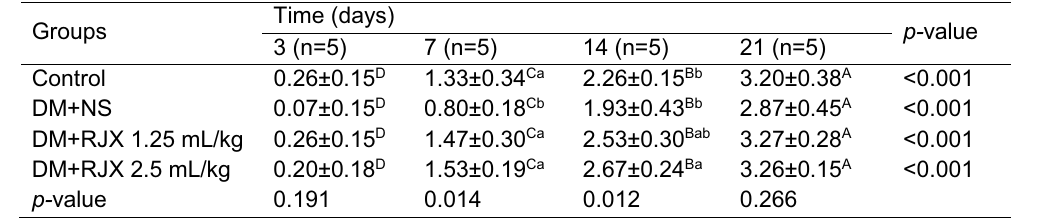
FIGURE 4 | Histopathological Scores of Wound Healing by Presence of Diabetes and Treatment Group. (A – D) Histopathological scores for wound healing for the healthy control vs. diabetic rats. The depicted scores represent the median and min-max. Statistical signi fi cance between groups is shown by *p<0.05 as compared to the healthy control group, and # p<0.05; ## p<0.01 as compared to the DM+NS group. Kruskal Wallis and Mann Whitney U tests were used for comparing the results among the different treatment groups. (E) Histopathological scoring system for wound healing. (E) Histopathological Scores of Wound Healing. On days 3, 7, 14, and 21, fi ve rats in each group were randomly selected. The depicted histopathological score data represent the mean and standard deviation. A,B,C,D Means in a row with different superscripts are statistically different (p<0.05). a,b Means in a column with different superscripts are statistically different (p<0.05). Kruskal Wallis and Mann Whitney U tests were used for comparing the results among different treatment groups or different